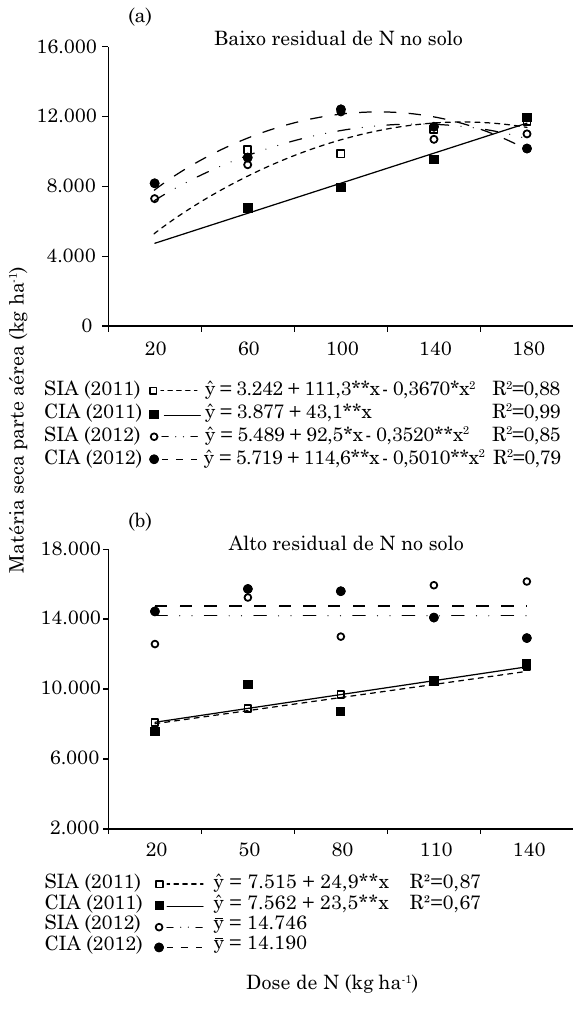
Figura 1. matéria seca da parte aérea do trigo em função de doses de nitrogênio e da inoculação ou não com Azospirillum brasilense . sia: sem inoculação com A. brasilense ; e cia: inoculação com A. brasilense . ** e * : significativos a 1 e 5 %, respectivamente, pelo teste